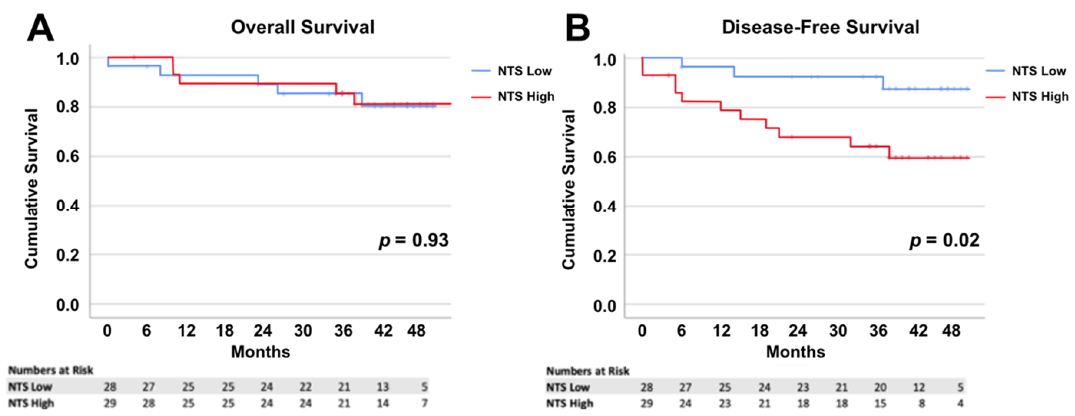
Figure 4. Kaplan Meiers curves of overall survival (OS) of subgroups with high and low expression of Neurotensin (NTS) in cancer ( A ), and disease-free survival (DFS) for subgroups with high and low expression of NTS in cancer ( B ).